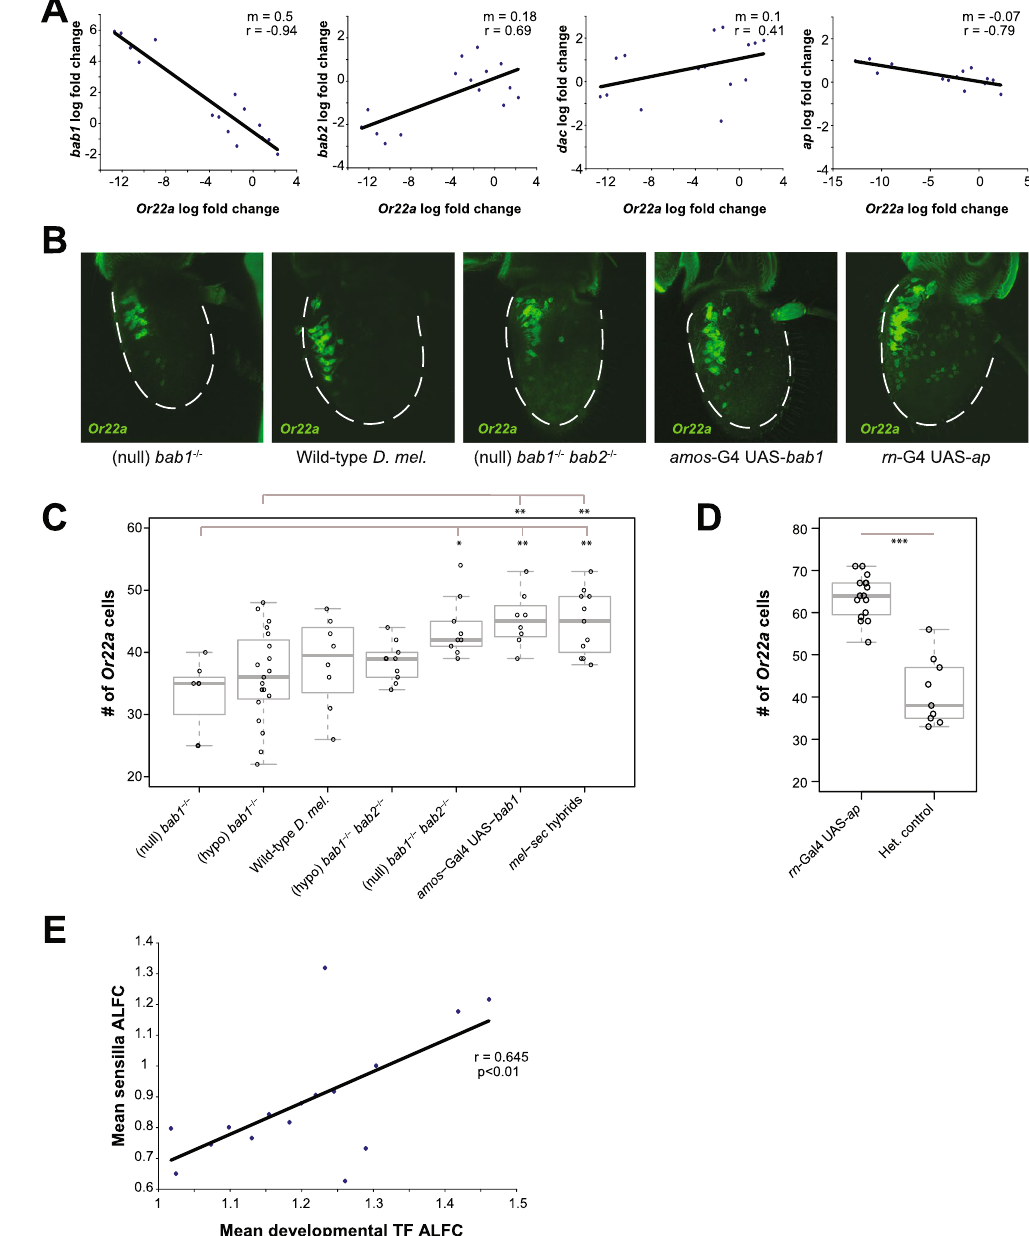
Figure 6. Relationship between highly variable TFs and highly variable ORs. (A) Plots of interspecies pairwise log fold change for Or22a against interspecies pairwise log fold change for pre-patterning TFs known to be involved in ab3 sensilla development. Solid lines indicate a linear regression, with m indicating the slope of the line and r indicating Pearson’s correlation coefficient. (B) Reporter analysis for Or22a expression in different mutant and overexpression backgrounds, arranged according to level of Or22a expression, using an Or22a - mCD8GFP promoter-fusion marker. (C) Quantification of changes in the number of Or22a -GFP cells when bab1 and bab2 expression is manipulated in different ways, with sechellia-melanogaster hybrids included for comparison. Statistical comparisons show results for ANOVA + Tukey’s HSD ( * p < 0.05, ** p < 0.01). (D) Increase in the number of Or22a GFP-positive cells when ap is overexpressed with a rn -Gal4 driver, compared to a heterozygous control lacking the Gal4 driver (p < 0.01, Student’s t-test, n = 9). (E ) Variability of OR genes grouped by sensilla subtypes plotted against the variability of the transcription factors known to be involved in its development (see Table S1) shows positive correlation (Pearson’s coefficient = 0.645, p < 0.01, n = 16). Each point represents the mean ALFC for all OR genes from a sensilla subtype plotted against the mean ALFC during T1-T3 for all transcription factors known to be involved in the development of that sensilla subtype. The ab3 and ab4 sensilla were removed as mathematical outliers (see